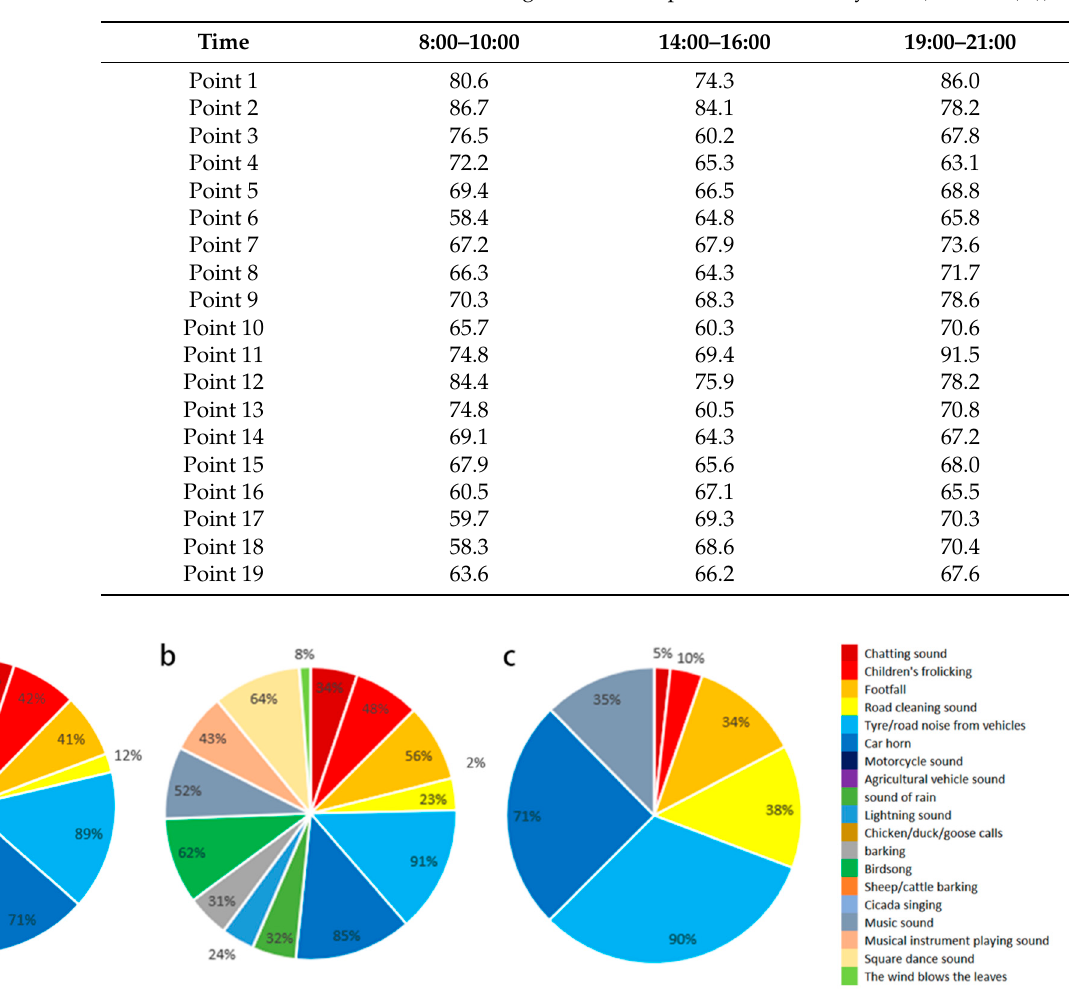
Table 3. The maximum value of SPL during the different periods in the study area (Unit: dB(A)).